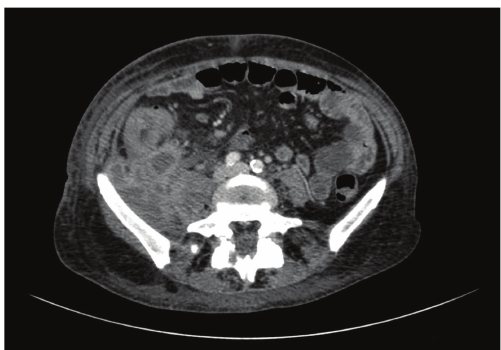
Figure 1: Computed tomography (CT) scan of the abdomen showed the mass occupying the retroperitoneal space and infiltrat- ing the ascending colon.